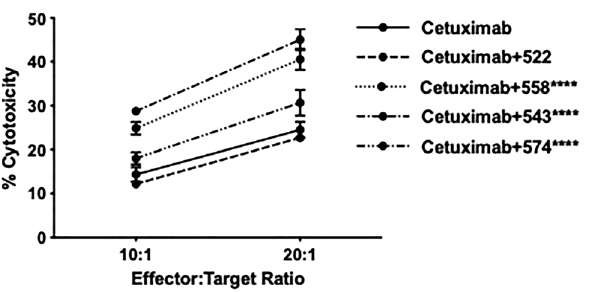
Figure 3. ADCC assay with human PBMCs (LDH based readout). 558, 543, 574 (1 μM) improved cetuximab-mediated ADCC. Percentage cytotoxicity depicted in figure. (****P < 0.0001 for cetuximab v/s cetuximab + 558/543/574 at Effector:Target ratio 20:1, P < 0.001 for cetuximab v/s cetuximab + 558/543 at Effector:Target ratio 10:1, P < 0.05 for cetuximab v/s cetuximab + 574; two-way ANOVA with multiple